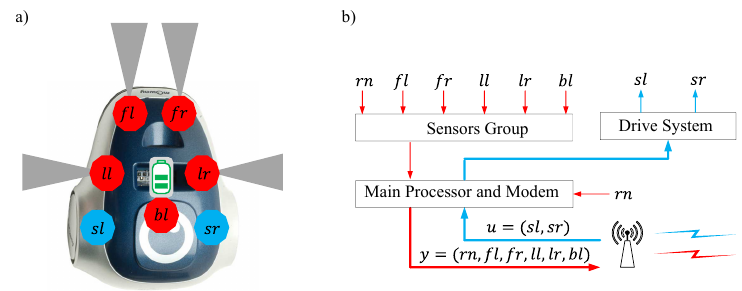
Figure 9. Sensors and actuators of the mOway robot: ( a ) position and orientation of the IR obstacle sensors ( fl , fr , ll , lr ), the battery sensor ( bl ), and the wheel actuators ( sl , sr ); and ( b ) flow diagram for the communication between sensors, actuators and the RF interface.